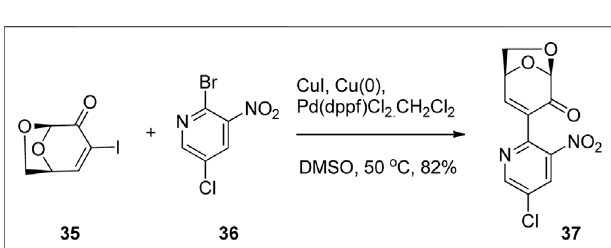
FIGURE 11 | Antimicrobial and anticancer derivatives of LGO via cross- coupling reactions.